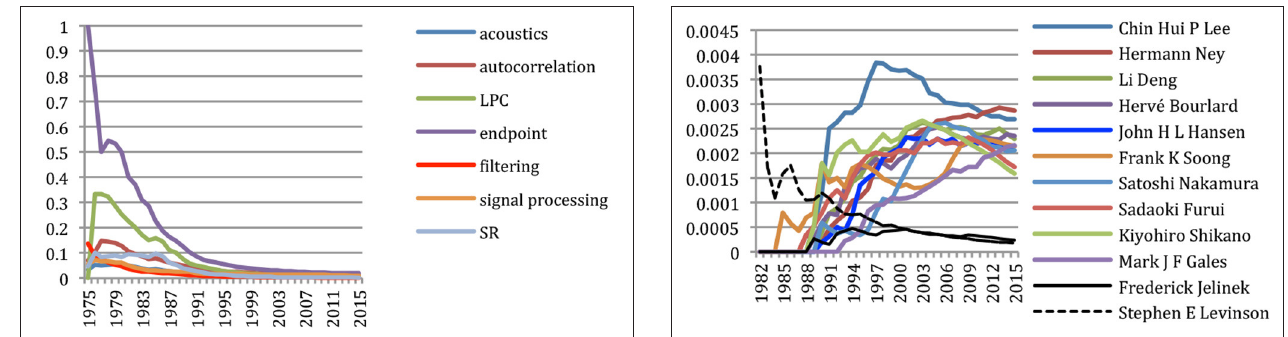
FIGURE 16 | Authors’ contributions to HMM in SNLP (% of all papers).